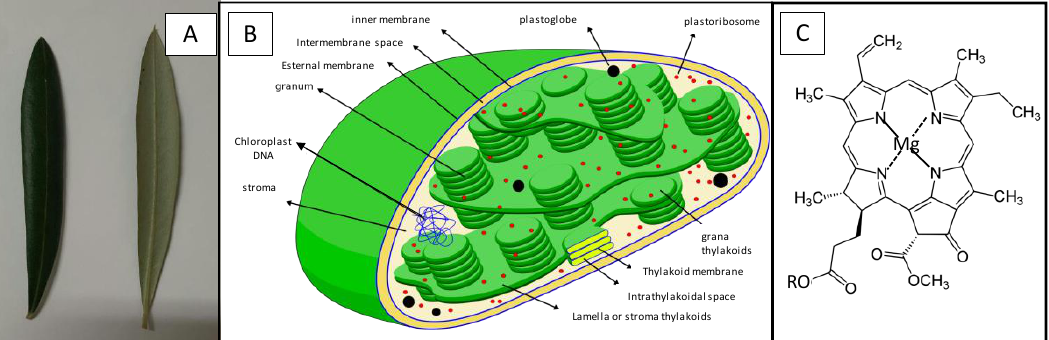
Figure 3. ( A ) Picture of olive leaves. ( B ) Structure of chloroplast, responsible for photosynthesis (Source: Miguelsierra/CC BY-SA (https://creativecommons.org/licenses/by-sa/4.0)). ( C ) Chlorophyll A structure where R denotes the phytol chain.